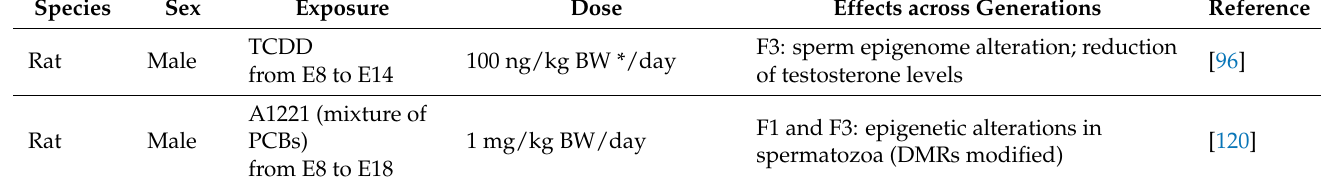
Table 5. Persistent environmental contaminant-induced effects in model animals across